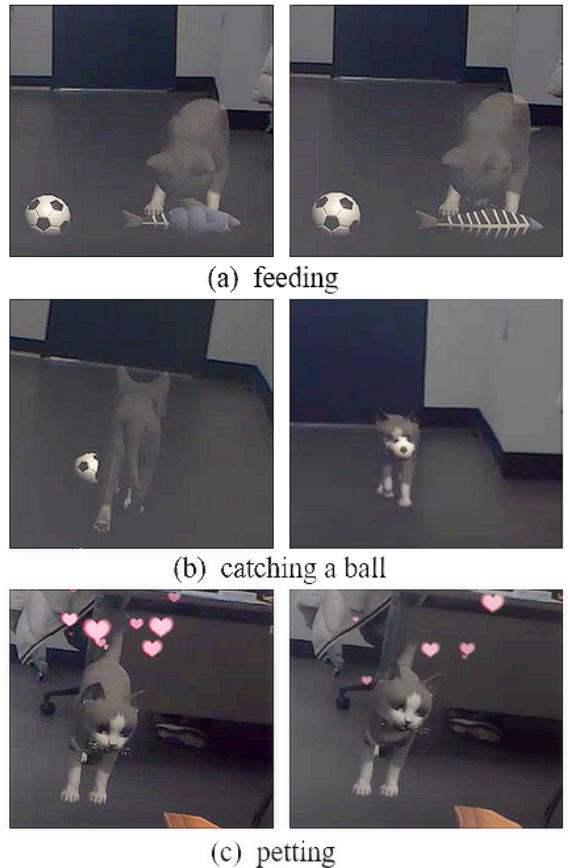
Figure 3. Examples of interaction with